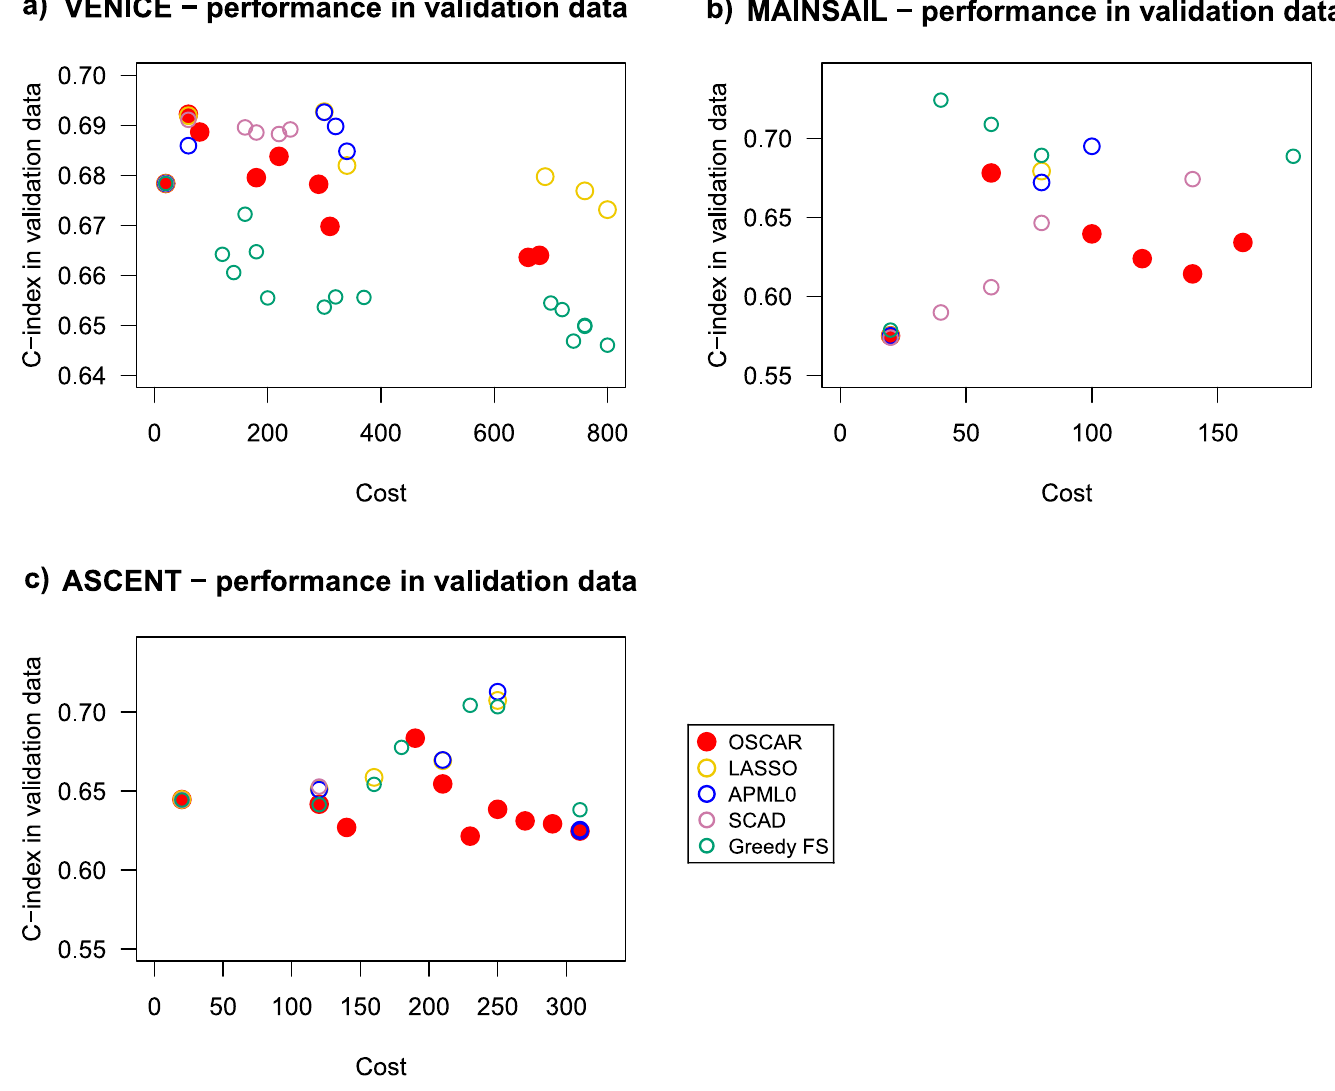
Fig 8. Model accuracy in the validation data cohort for OSCAR (red filled circle), LASSO (yellow hollow circles), APM- L 0 (blue hollow circles), SCAD (light purple hollow circles), and Greedy FS (green hollow circles) in the three trial data cohorts VENICE, MAINSAIL, and ASCENT. Only the performance of the models in the corresponding approximated Pareto-fronts are presented (see Fig C in S1